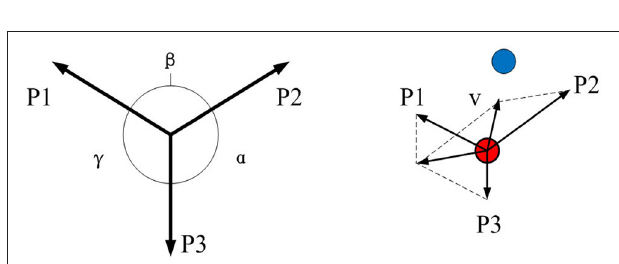
FIGURE 3 | The diagram of MI-based control vector decomposition. The classification probabilities are marked as P1, P2, P3 which is mapped to three vectors. The angle between each two vectors is 120 ◦ and the length of the vector is equal to the value of the